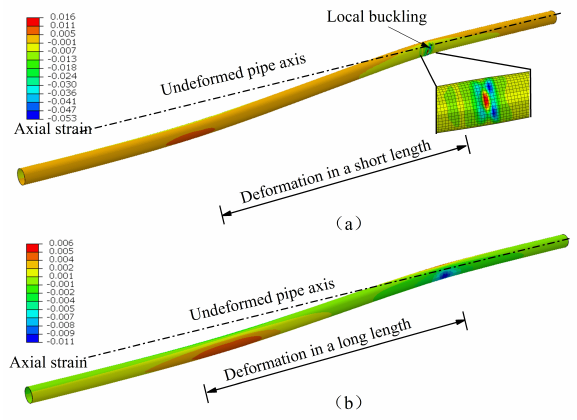
Fig. 3. Axial strain of buried pipe (a) pipe buried in soil; (b) pipe protected with EPS